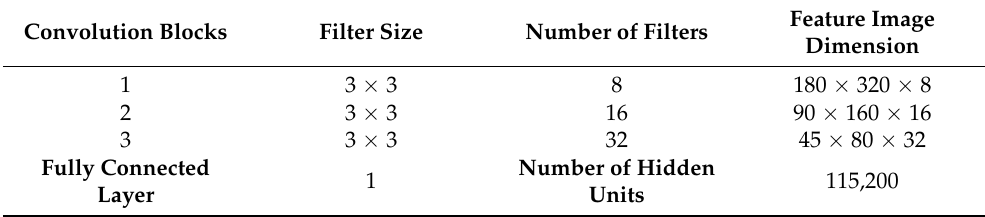
Table 2. Structure parameter table of CNN with an image resolution of 180 × 320.